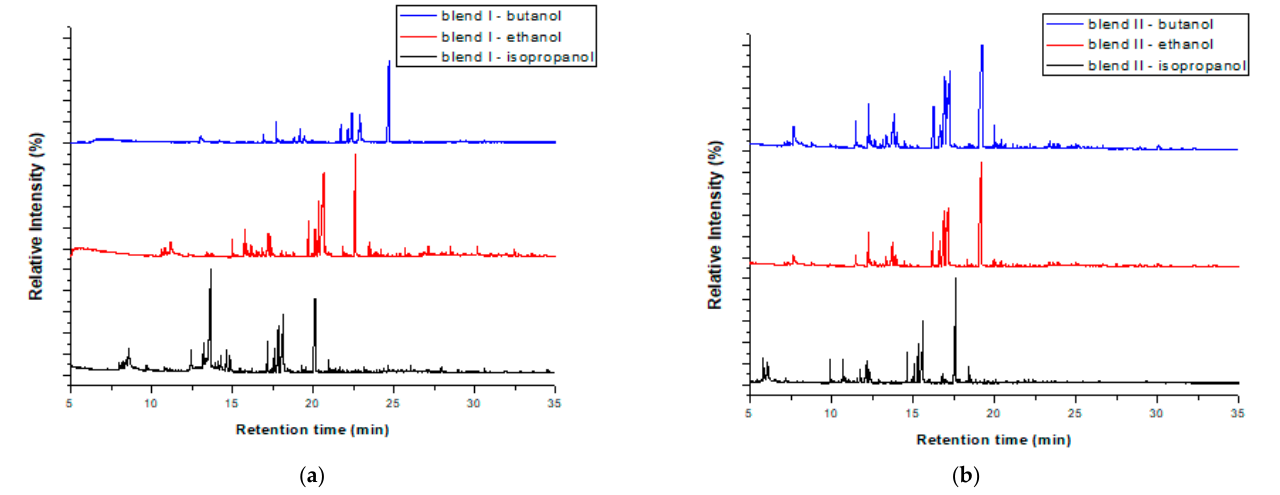
Figure 8. GC/MS chromatograms after pyrolysis of the blends after soxhlet extraction for 6 hr. with isopropanol, ethanol and butanol for blend I ( a ) and blend II ( b ).